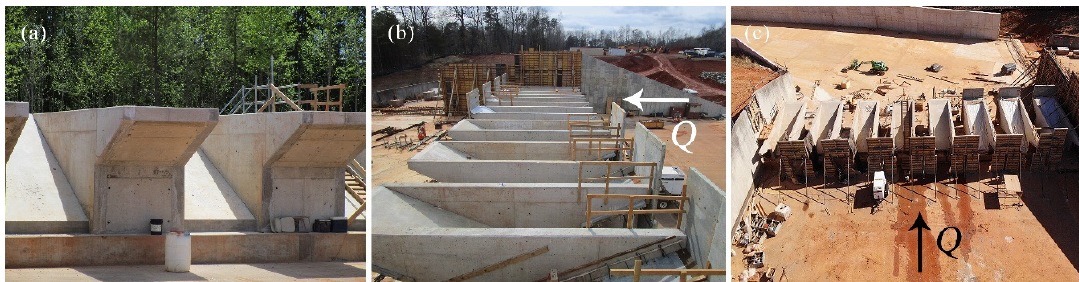
Figure 1. Overview of the new Piano Key weir (PK weir) under construction at West Fork of Eno Reservoir Dam (North Carolina, USA). ( a ) Looking upstream; ( b ) across weir towards right wingwall, and ( c ) looking downstream. Photos courtesy Schnabel Engineering.